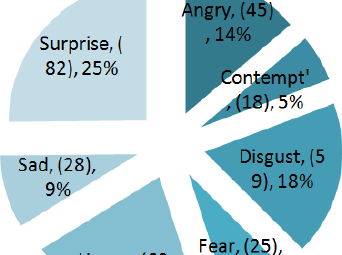
Figure 5. Example of obtaining LGP